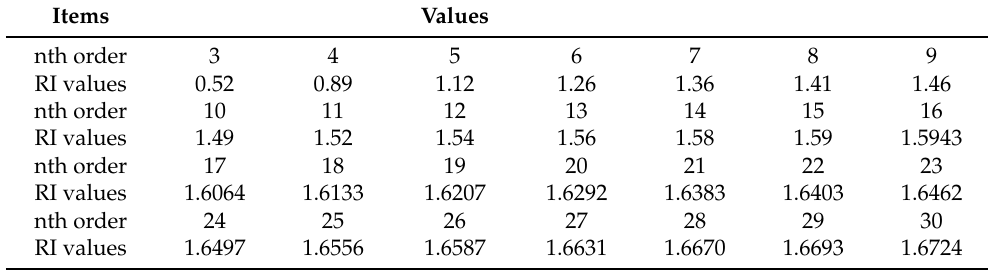
Table 2. Stochastic Consistency